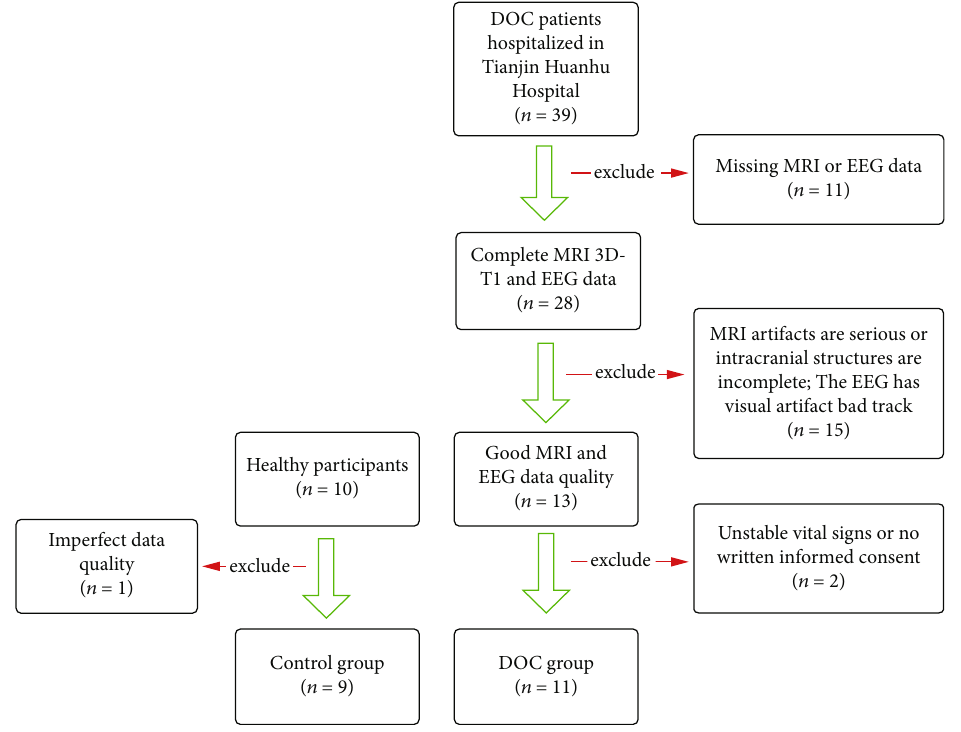
Figure 1: The CONSORT diagram. Table 1: Clinical data of participants in the DOC